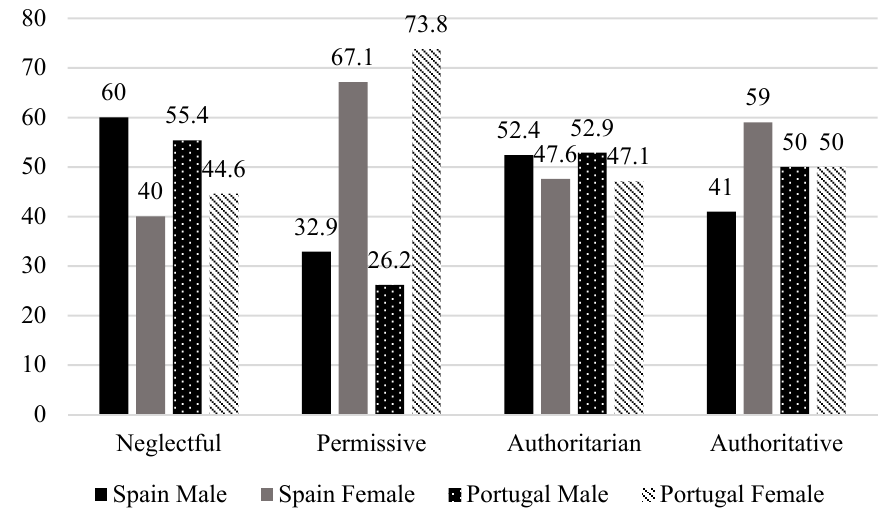
Figure 1. Parenting style distribution by country.